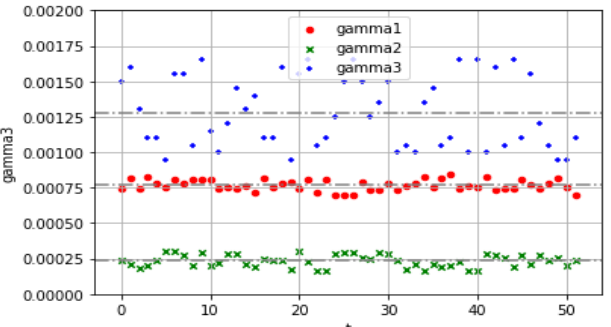
Figure 7. Beta parameters learning result.